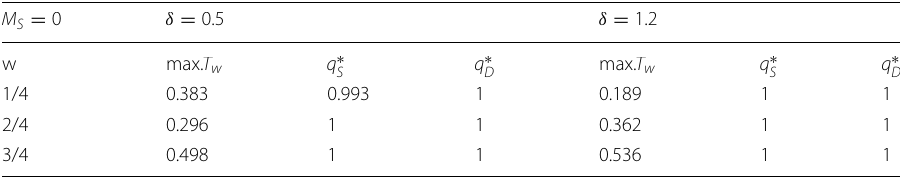
and q ∗ for which the weighted sum throughput is maximized when the S D